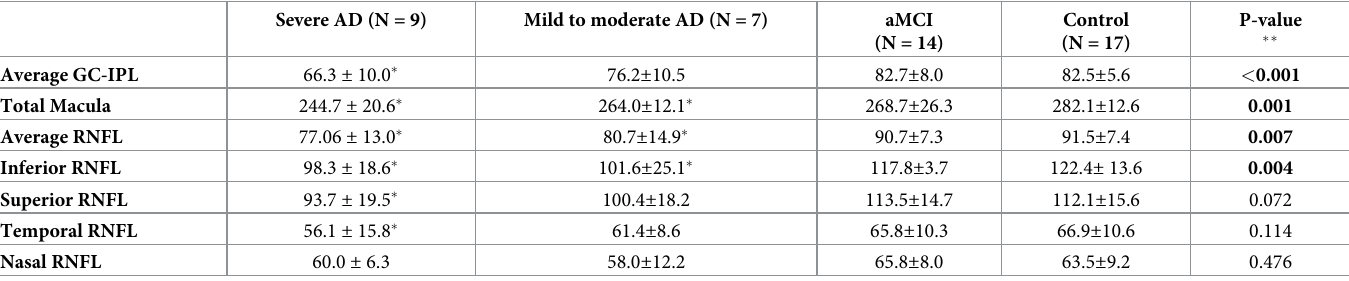
Table 2. The GC-IPL, total macula, and RNFL thickness measurements in the four groups. Severe AD (N =